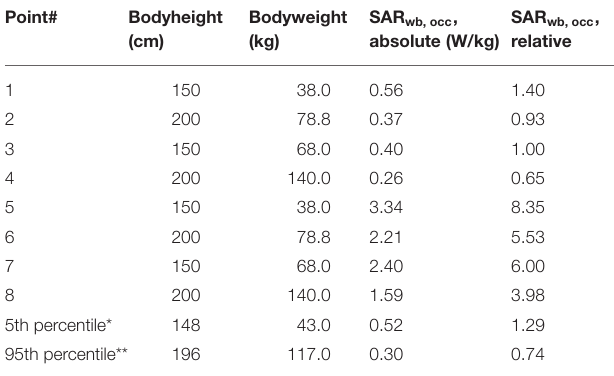
TABLE 1 | Numerical values for reference points 1–4 according to Figures 3 and 5–8 according to Figure 2 (based on 33).